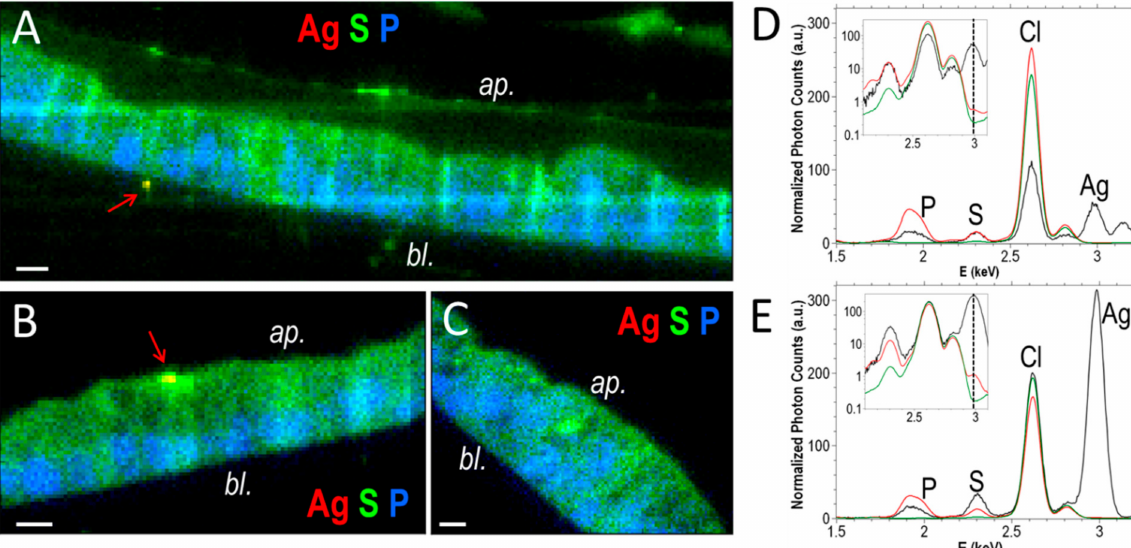
Figure 5. ( A – C ) Silver (red), sulfur (green) and phosphorous (blue) distribution in gastrointestinal epithelia exposed to: ( A ) Digested AgNPs, ( B ) undigested AgNPs, and ( C ) digested Ag salt. Elemental distributions were extracted from micro-beam X-ray fluorescence ( µ XRF) hyperspectral images. Scale bars = 10 µ m. The apical (ap.) and basolateral (bl.) sides of the epithelia are indicated over the images. ( D , E ) Sum XRF spectra of putative AgNPs (black curves), particle-free cells (red curves) and sample-free resin (green curves) in epithelia exposed to: ( D ) Digested AgNPs, and ( E ) Undigested AgNPs. The areas of interest were selected on maps A and B for digested and undigested AgNPs, respectively, and the sum spectra were normalized by the number of selected pixels. Red arrows in panels A and B point out an intense and localized Ag signal (red appearing yellow due to the co-localization with S, represented in